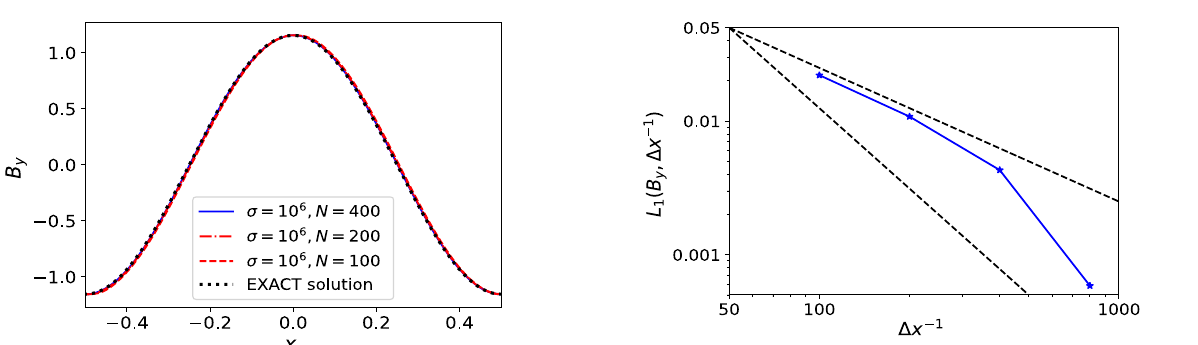
Fig. 2 The magnetic field component B y at t = 2 is shown in the large amplitude circularly polarized Alf´ven waves. The blue solid, red long dashed-dotted and red dashed lines represent results with σ = 10 6 and N = { 100 , 200 , 400 } , respectively. The black dotted line stands for the analytical solution